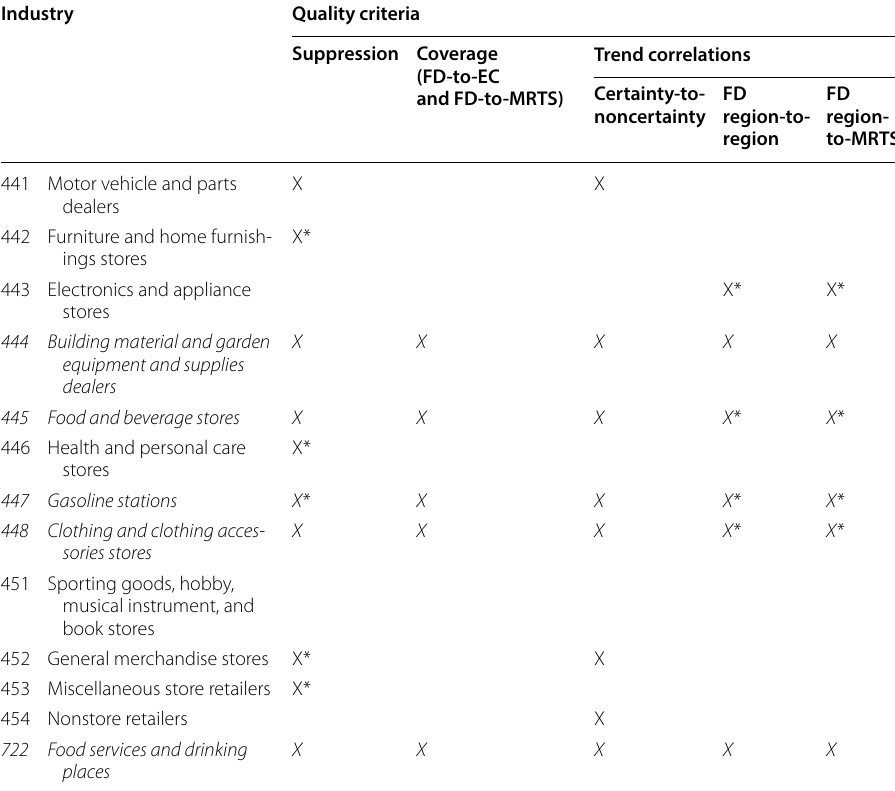
Table 1 Summary of quality criteria by industry